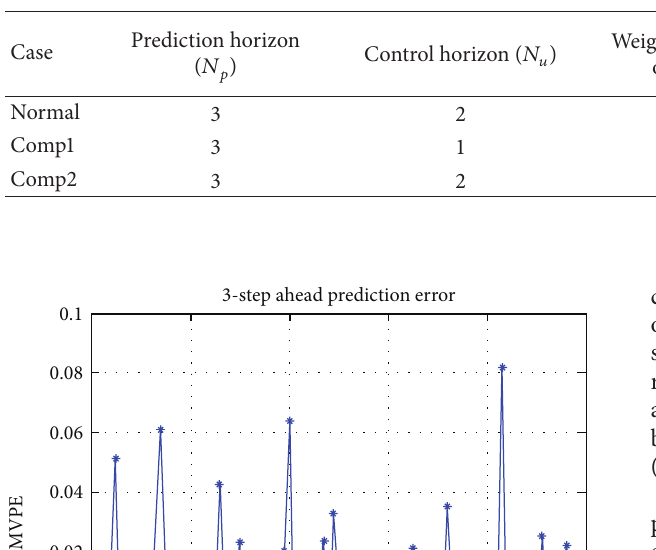
Table 1: Parameters of DNN-ADNMPC control strategies.